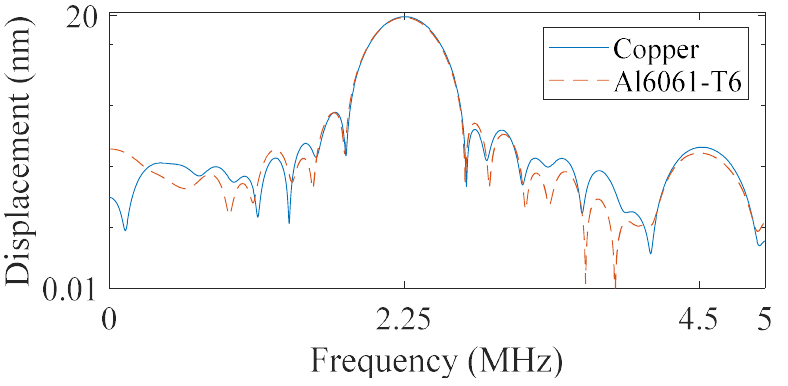
Figure 7. Typical frequency-domain signals for copper (blue solid line) and Al6061-T6 (brown dotted line) specimens.